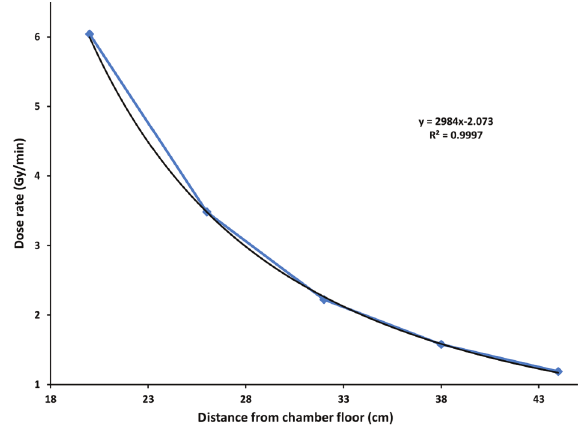
Figure 6. Dose distribution along the beam central axis varying the tray position from height levels 1 to